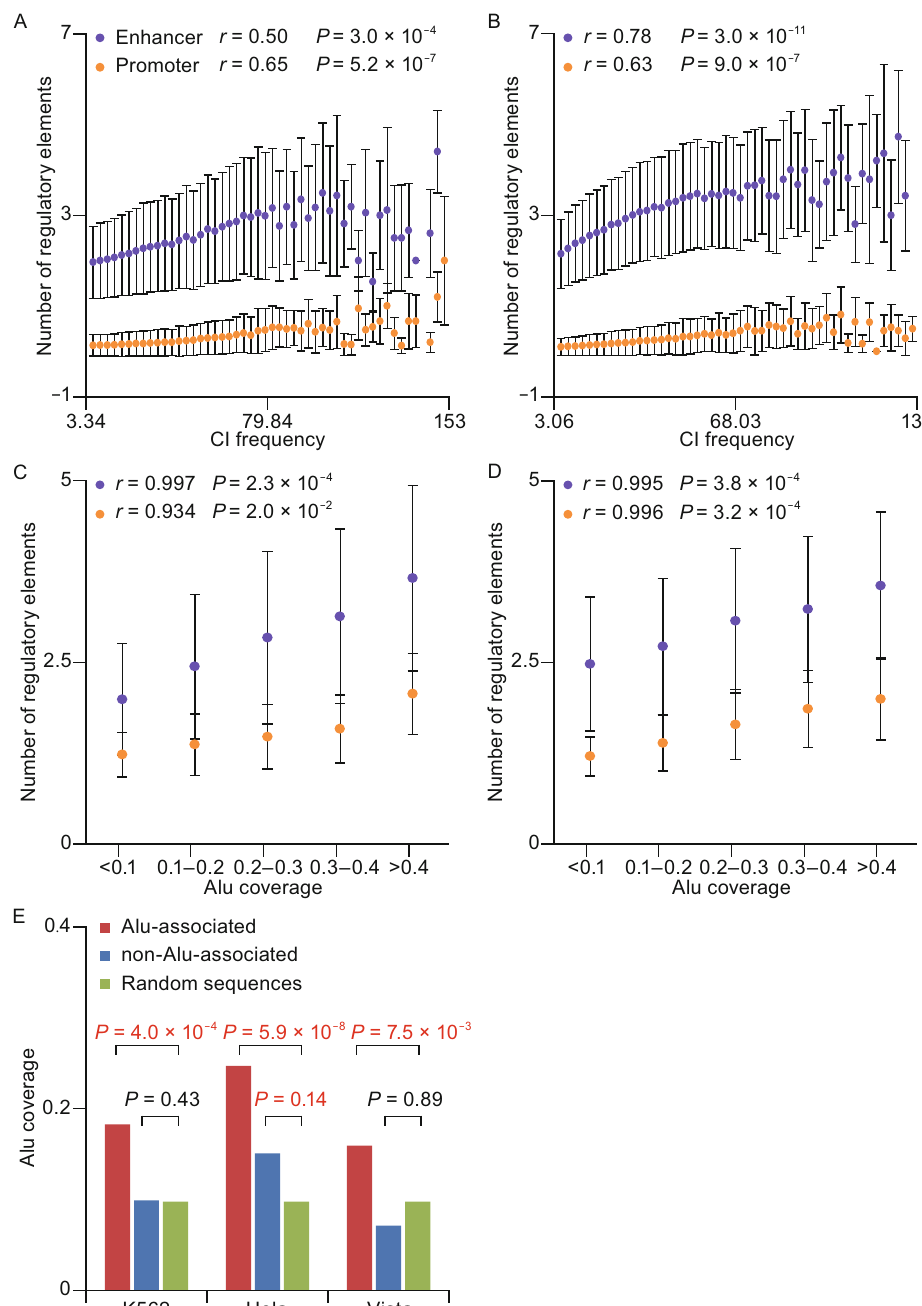
Figure 4. Mean numbers of enhancers and promoters demonstrated correlation with CI frequencies. (A and B) The mean numbers of active enhancer regions and active TSS regions were both positively correlated with CI frequencies in two cell lines (A: hESC; B: IMR90 fi broblasts). (C and D) The mean numbers of active enhancer regions and active TSS regions were both positively correlated with Alu coverage of the bin-pairs they belonged to in two cell lines (C: hESC; D: IMR90 fi broblasts). (E) The Alu coverage in the 40 kb regions centered on the predicted enhancer peaks of K562 cell line, HeLa cell line, and in VISTA enhancer browser. The Alu -overlapped enhancers in the two cell lines and VISTA enhancer browser were all signi fi cantly different from the background, which is the mean Alu coverage of a random 40 kb region in human genome (Binomial test, P < 0.01), and the non- Alu -overlapped enhancers in HeLa cell line were also signi fi cantly different from the random distribution (Binomial test, P <